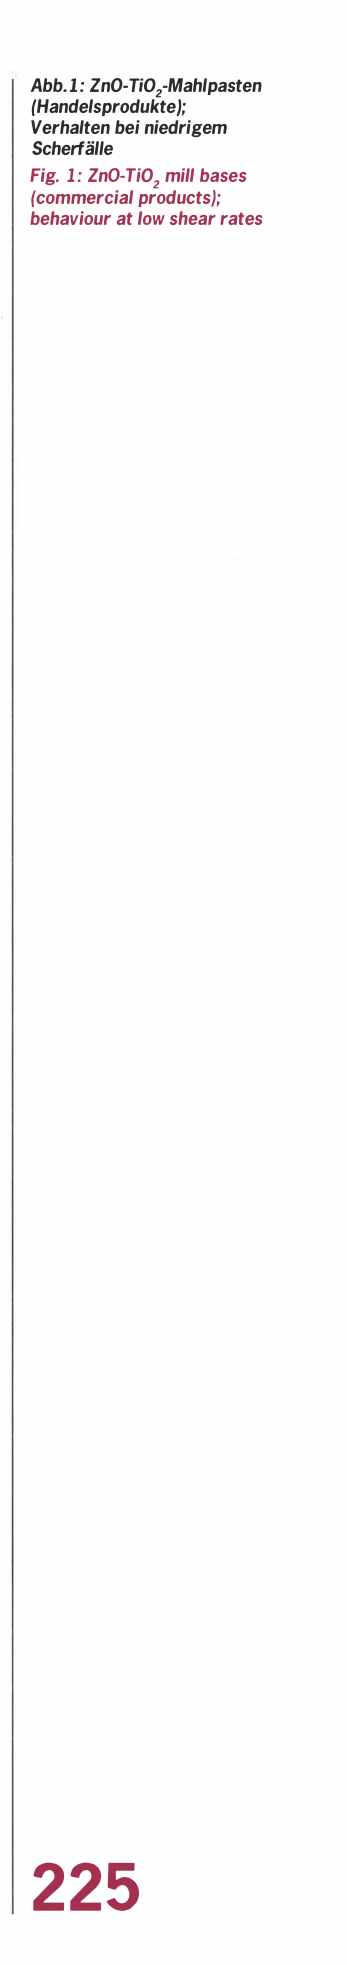
Fig. 1: Zn0-Ti0 2 mill bases (commercial products}; behaviour at low shear